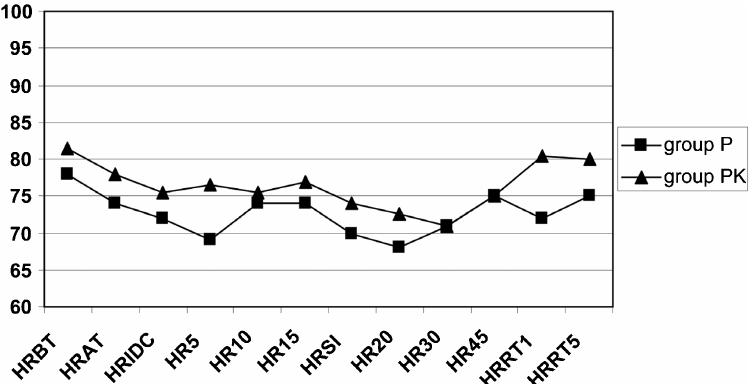
Figure 1 - Variation of heart rates relative to time. HRBT: Heart Rate Before tourniquet, HRAT: After tourniquet, HRIDC: Inflation of the distal cuff, HRSI: Surgical incision, HRRT1: First minute after the release of the tourniquet, HRRT5: Fifth minute after the release of the